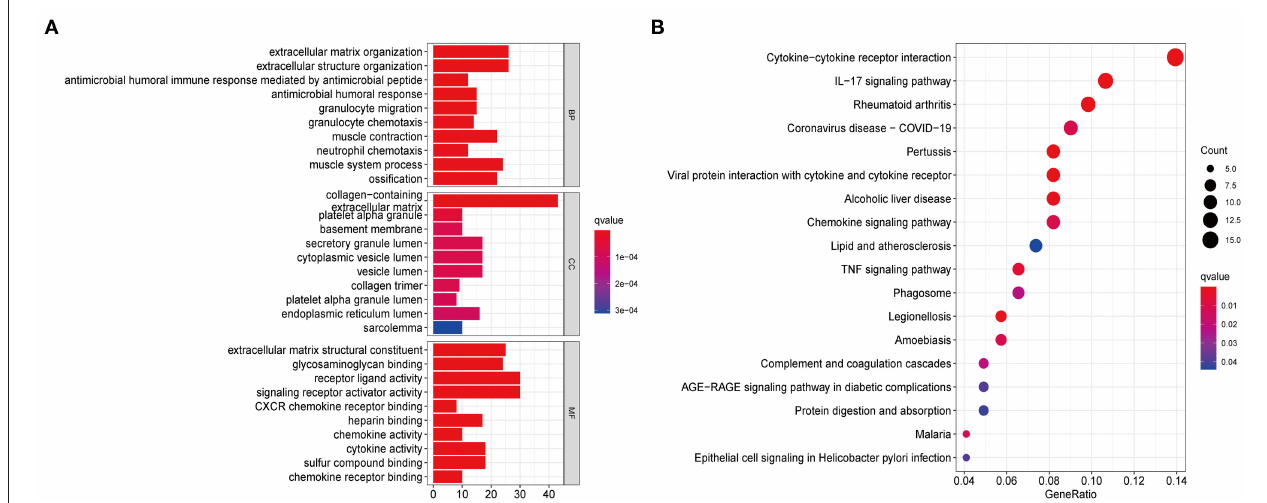
FIGURE 3 | Functional enrichment analysis based on DEGs between distinct necroptosis molecular subtypes. (A) GO functional enrichment analysis with bar plot (BP, biological process; CC, cellular component; MF, molecular function). (B) KEGG pathway enrichment analysis with bubble plot.